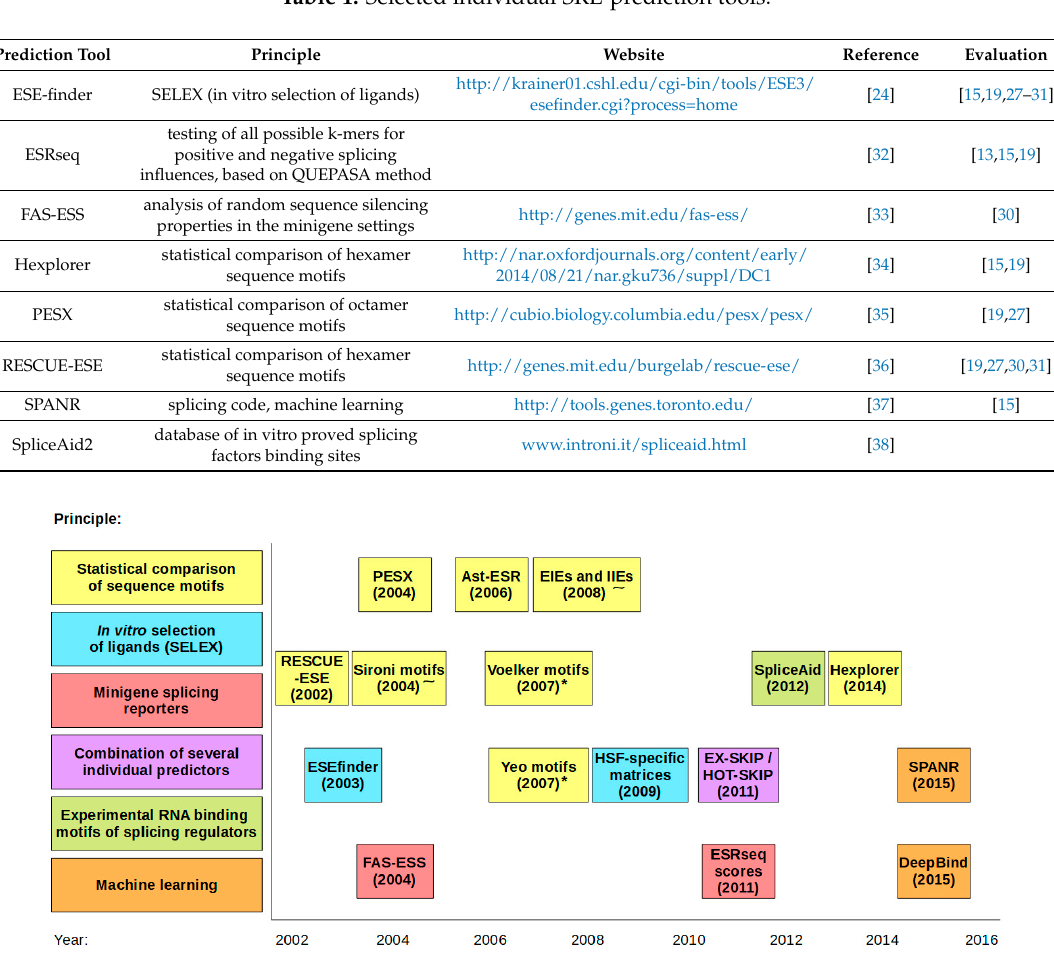
Table 1. Selected individual SRE-prediction tools.